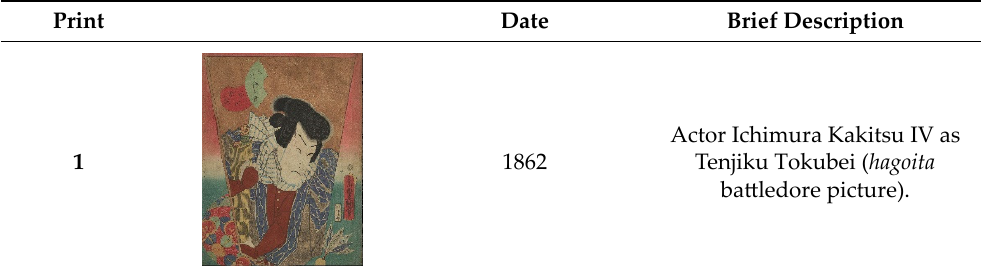
Table 1. The woodblock prints by Utagawa Kunisada investigated by imaging and spectroscopic techniques.